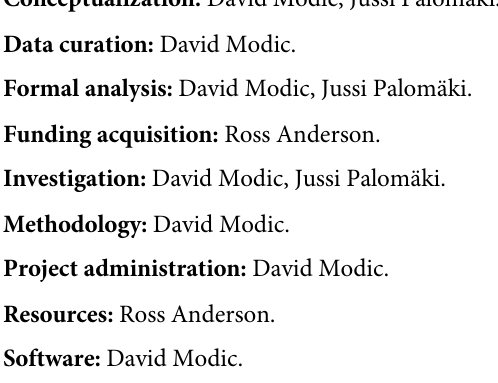
S1 Table. Factor loadings and communalities based on a Principal Axis Factoring with Oblimin Rotation for 54 items from susceptibility to persuasion—II scale on main sample (n = 500). S2 Table. Factor loadings for susceptibility to persuasion scale using Principal Axis Factor- ing with Oblimin Rotation (n = 6609). S3 Table. Spearman rho correlations between plausibility and StP-II with its subscales. S4 Table. Standardised factor loadings / Correlations across items in factors for StP-II (n = 279) in confirmatory factor analysis. S5 Table. Standardised factor loadings / Correlations across items in StP-IIB factors (n = 279) in confirmatory factor